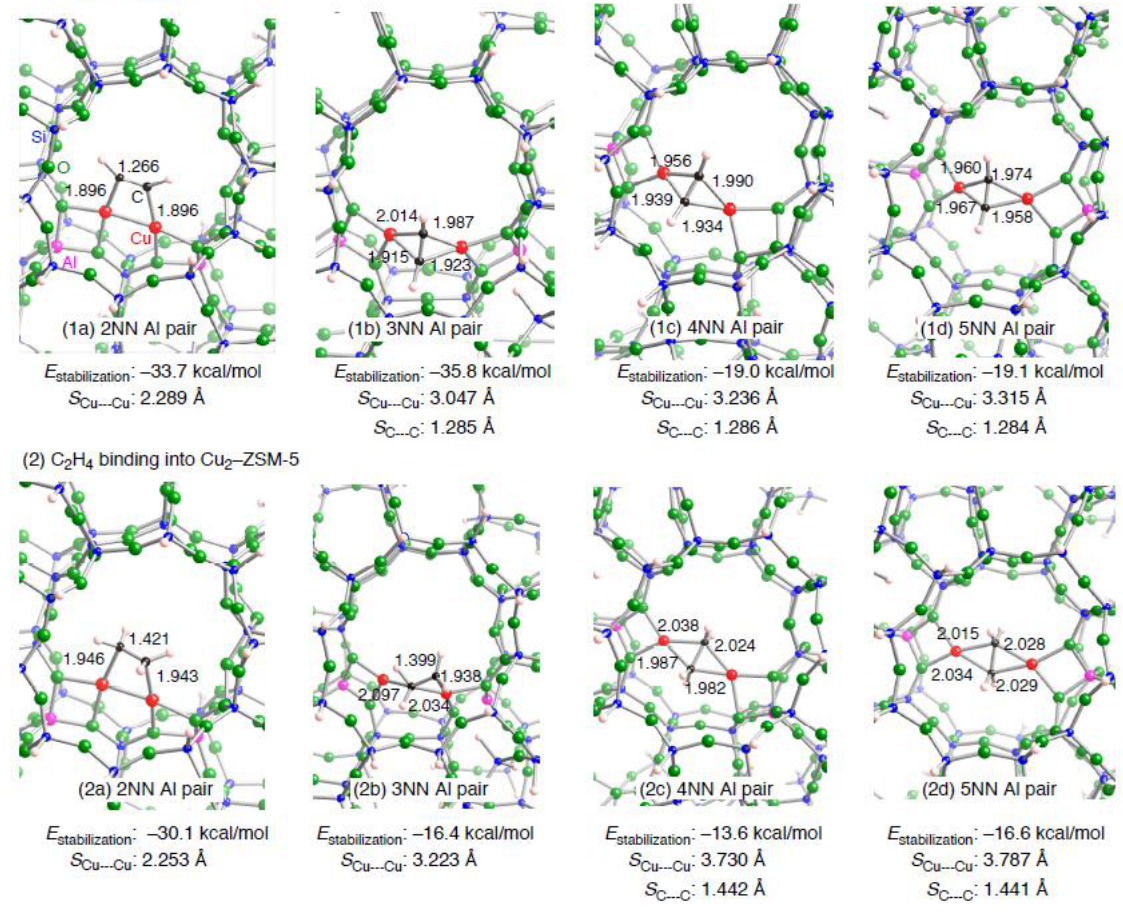
Figure 7. Local structures of four optimized structures for the binding of an unsaturated hydrocarbon ((1) C H or (2) C H ) into a dicopper active center embedded inside the 2 2 2 4 Al Si O H ZSM-5 model. The four types of optimized structure can be distinguished 2 90 151 66 by positions of double Si  Al substitution: the two substituted Al atoms within a ten-membered ring are (a) second nearest neighbor ( 2NN ), (b) third nearest neighbor ( 3NN ), (c) fourth nearest neighbor ( 4NN ), and fifth nearest neighbor ( 5NN ). Optimized bond lengths together with the Cu•••Cu separations are given in Å. The E are in